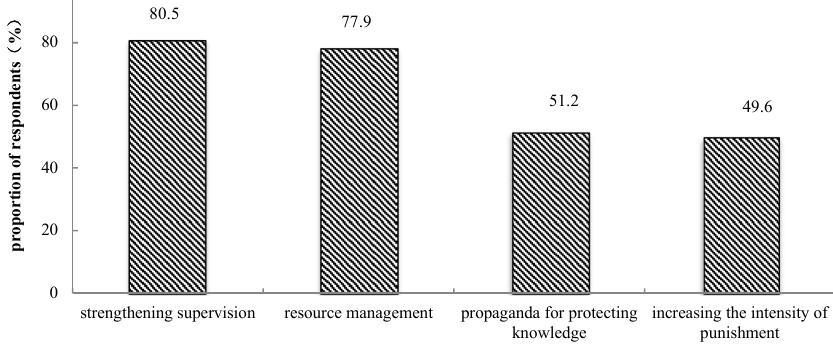
Figure 5. Main measures to prevent water pollution accident. Note: the same respondent ticked more than one alternative.